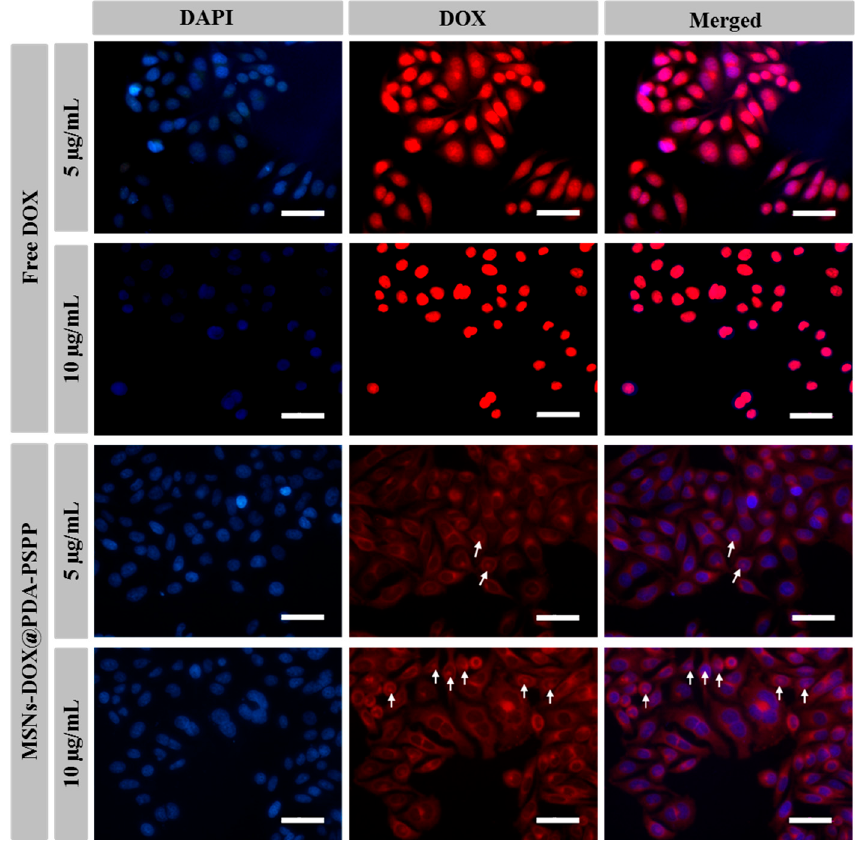
Figure 9. Fluorescence microscopy images of HepG2 cells after incubation with free DOX or MSNs- DOX@PDA-PSPP for 2 h at DOX concentrations of 5 µg/mL and 10 µg/mL. Scale bar = 50 µm. The MSNs-DOX@PDA-PSPP for 2 h at DOX concentrations of 5 µ g/mL and 10 µ g/mL. Scale bar = 50 µ m. white arrows indicated DOX successfully entered into the cell nuclei. The white arrows indicated DOX successfully entered into the cell